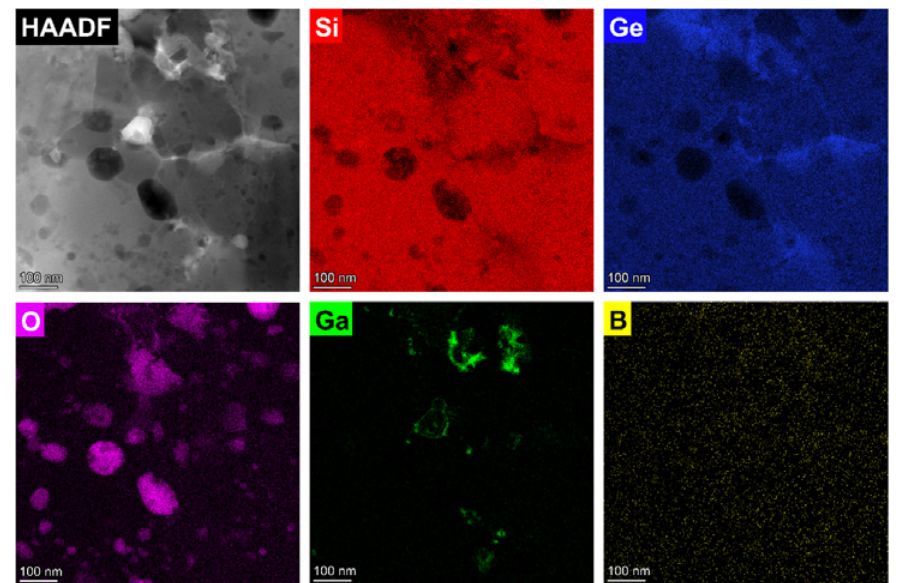
Fig. 4 HAADF-STEM image and corresponding TEM–EDS mappings for the dual oxide-composited sample at 1015 ℃ ( T s ).